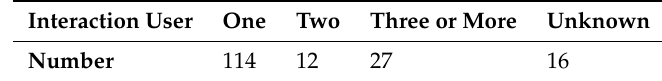
Table 5. Numbers of interaction users with tangible light in the review